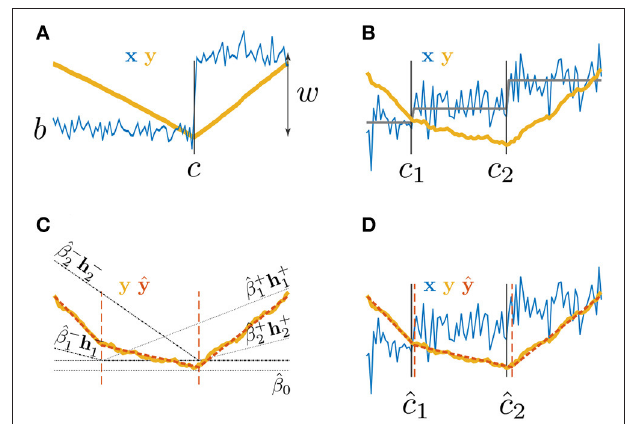
FIGURE 1 | Paired Adaptive Regressors for Cumulative Sum; (A,B) time series x with (A) one or (B) two step changes and their corresponding CUSUM transformation y ; (C) fitting y by a piecewise linear model ˆ y using two pairs of regressors h ± 1 and h ± 2 ; (D) the PARCS model fit ˆ y to the CUSUM transformation y of a time series x , returning estimates of multiple CPs, ˆ c 1 and ˆ c 2